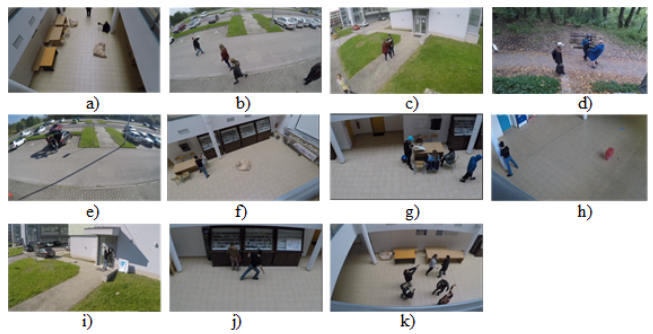
Figure 7. LoDVP Abnormal Activities dataset: ( a ) Begging ( b ) Drunkenness ( c ) Fight ( d ) Harass-